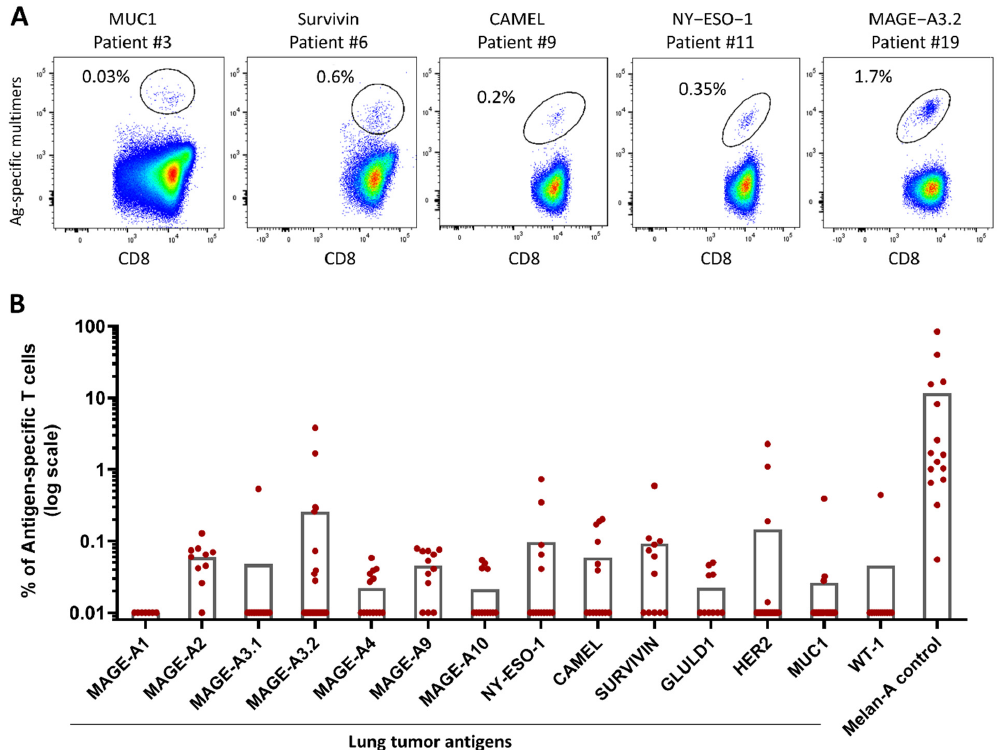
Figure 2. Specific CD8+ T-cell responses induced by PDC*line cells in lung cancer patients. PDC*line cells were loaded individually with selected HLA-A*02-restricted tumor peptides, mixed, and ir- radiated. The cells were cultured with patients’ PBMCs, and the proportion of antigen-specific CD8-positive T cells (ASTC) was measured using fluorescent multimers specific to each HLA-A*02- restricted peptide. ( A ) Examples of multimer labeling of ASTCs after coculture of patients’ PBMCs with loaded-PDC*line cells. Positive responses of five different patients are shown for five different antigens with pseudocolor dot plots made with FlowJo software. ( B ) Frequencies of ASTCs for all antigens after culture of patients’ PBMCs with tumor-peptide-loaded PDC*line cells. Each red dot represents a patient. When ASTCs were not detected, the frequency was the limit of detection, i.e., 0.01%. The bars show the mean of the